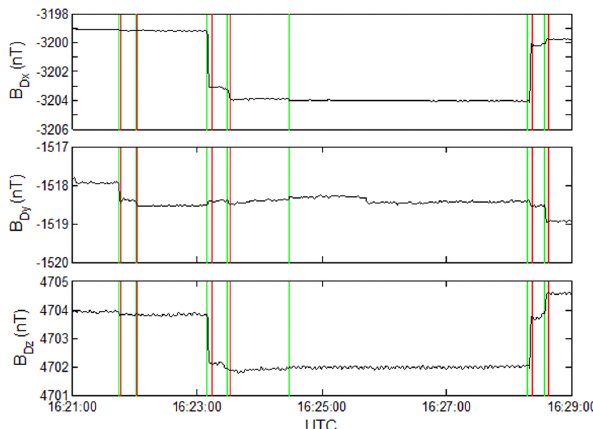
Fig. 3. Eight minutes of B Dx (t) measured on 14 July 2006 with the events (changes in the spacecraft magnetic field) detected by the fuzzy logic based algorithm marked. The green and red lines mark the start and end of these transient events, respectively.